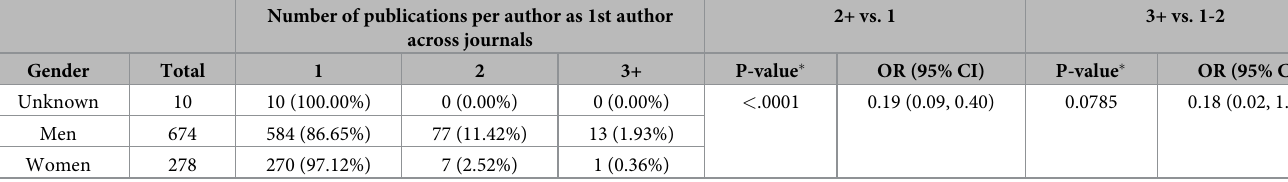
Table 7. First authors with multiple publications for all journals by